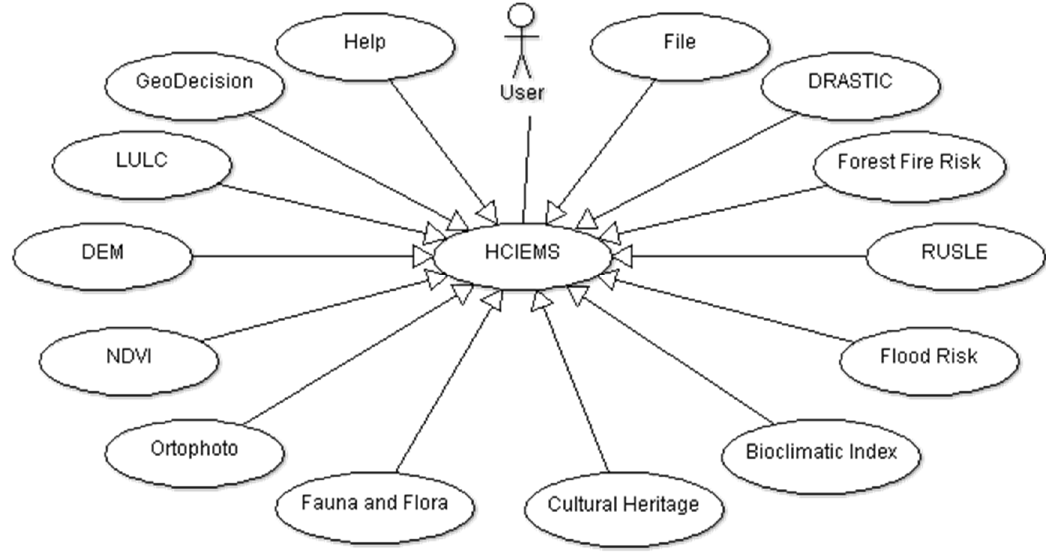
Figure 3. Herdade da Contenda Integrated Environmental Management System (HCIEMS) user case diagram. RUSLE, Revised Universal Soil Loss Equation and DRASTIC (Depth to groundwater (D), Recharge (R), Aquifer media (A), Soil media (S), Topography (T), Impact of the vadose zone (I) and hydraulic Conductivity (C)).